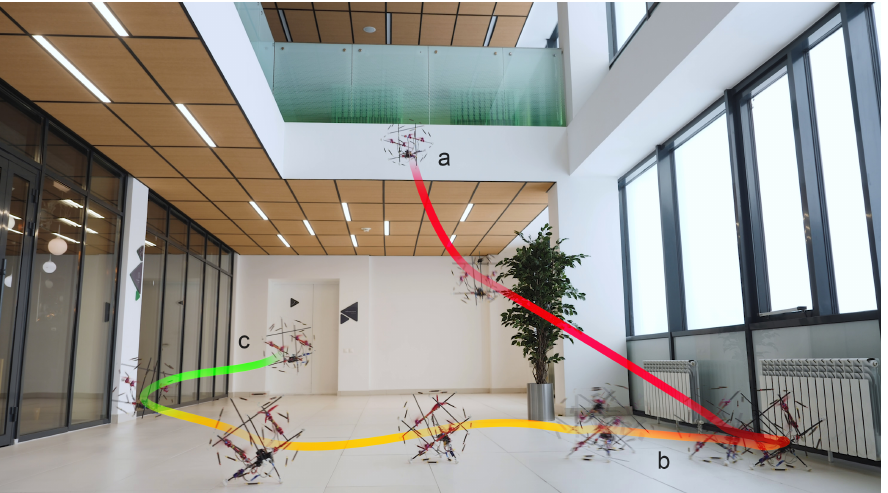
Figure 1. Tensodrone: a tensegrity-based quadrotor UAV; (a) flight, (b) crash landing, and (c)